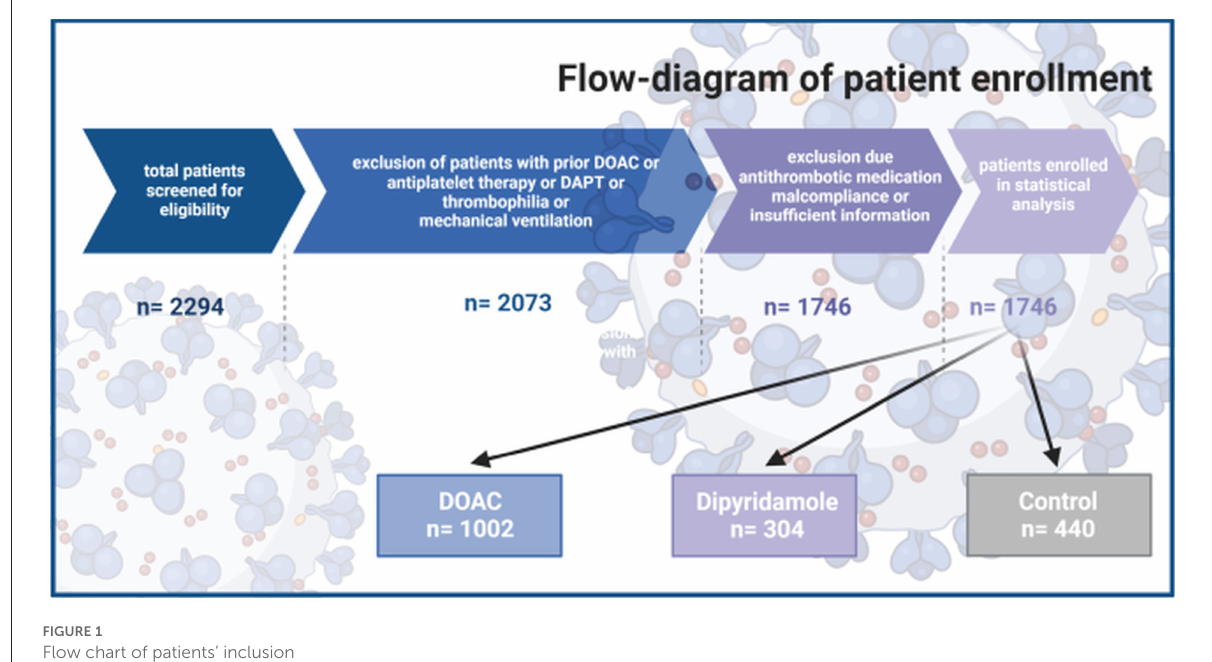
FIGURE1 Flow chart of patients’ inclusion